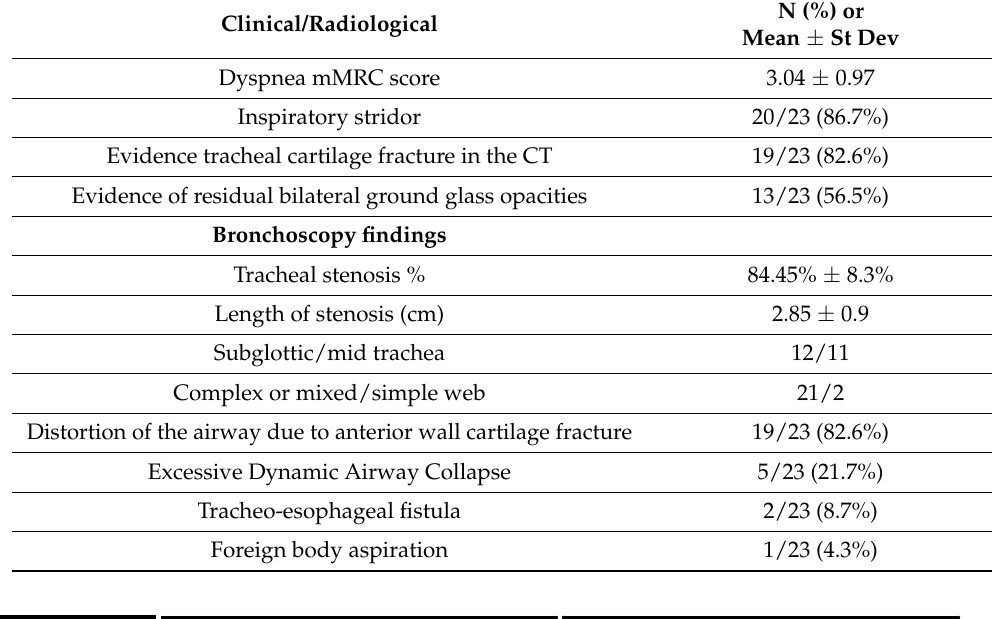
Table 2. Airway sequelae and bronchoscopy findings.